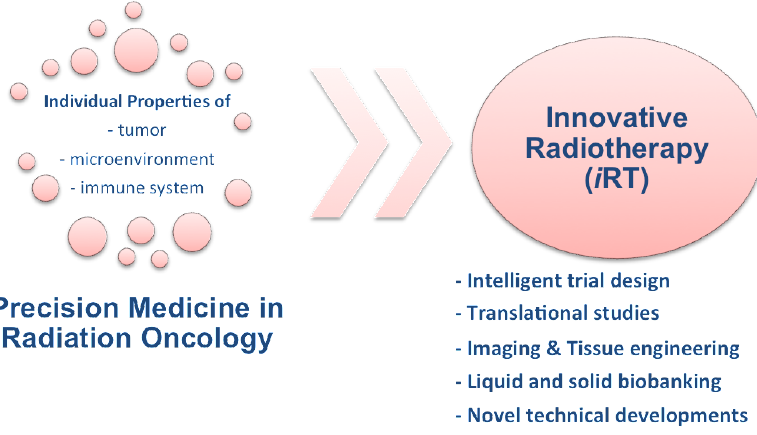
Figure 1. Precision medicine in the context of Innovative Radiotherapy (iRT).